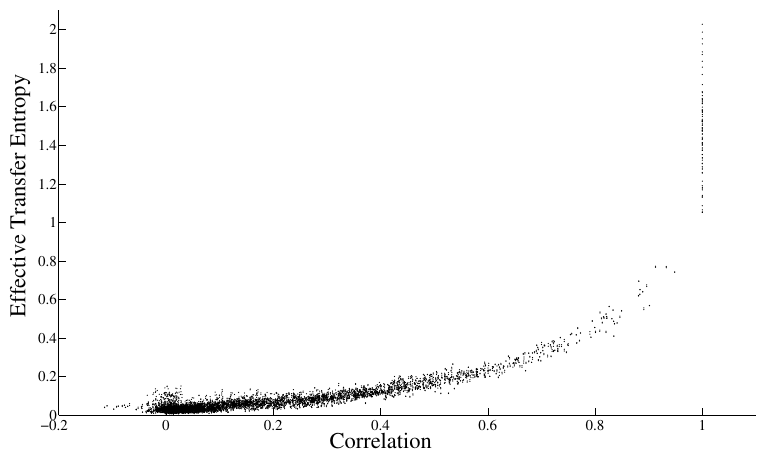
Figure 6. Correlation values of Sector 1 of the correlation matrix and Effective Transfer Entropy (ETE) of Sector 2 of the ETE